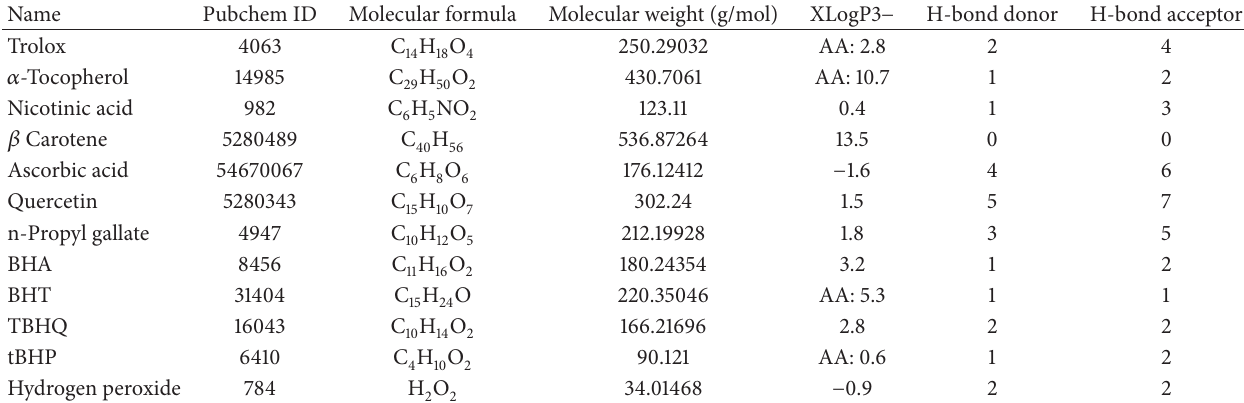
Table 2: Properties of the compound